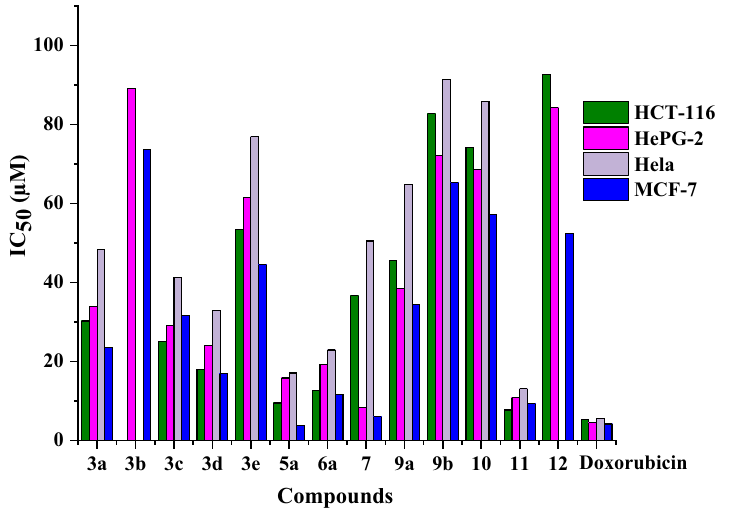
Figure 7. IC 50 of the cytotoxic activity of the examined compounds against human tumor cell